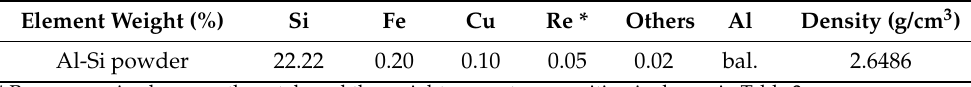
Table 2. Weight percent composition of Al-Si powder determined by